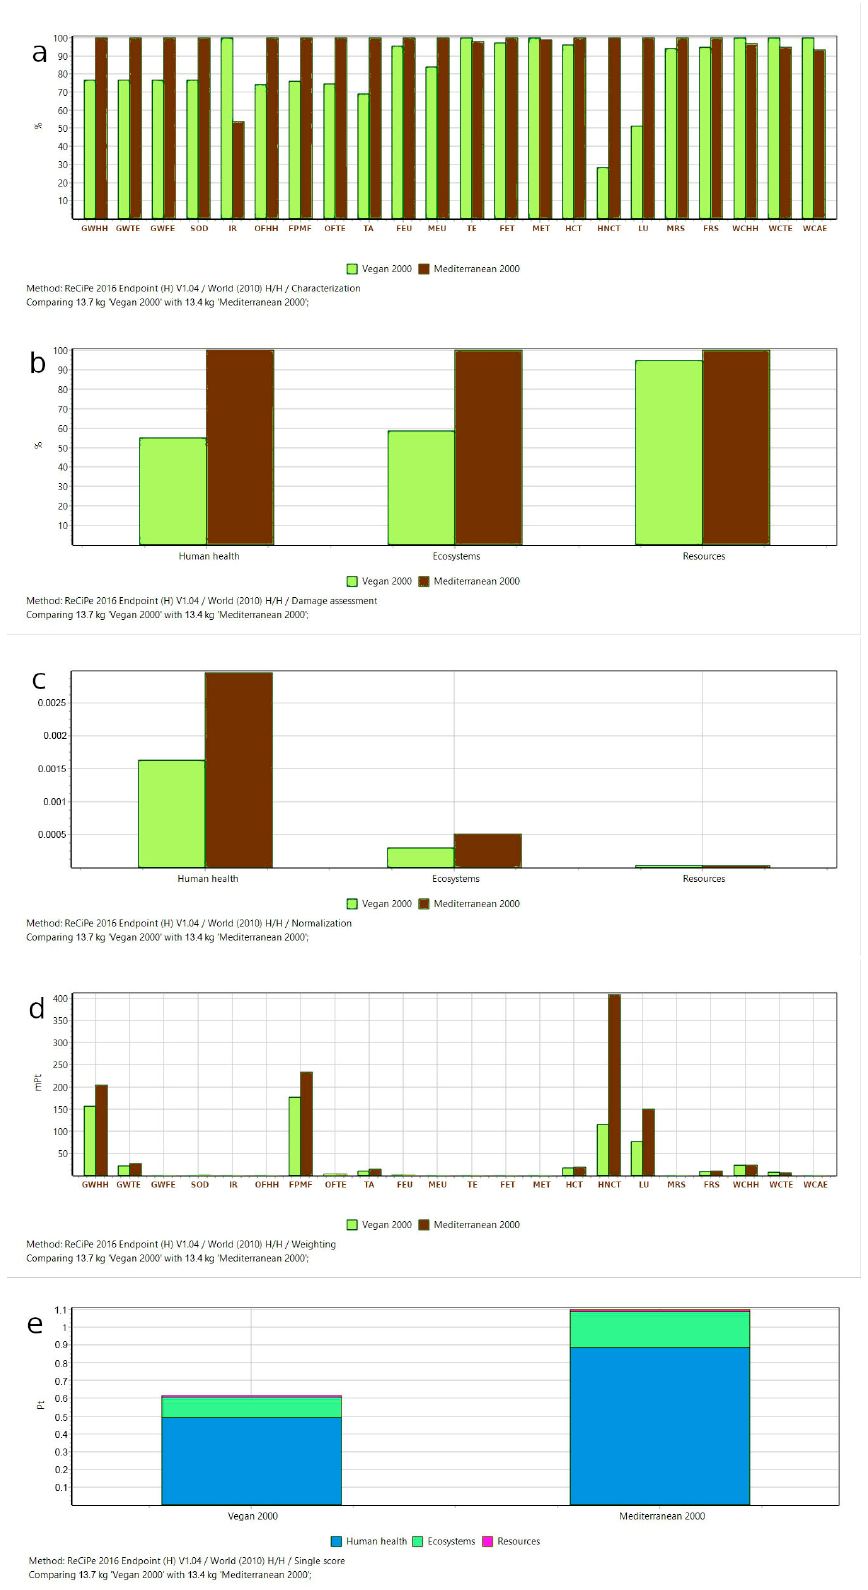
Figure 2. Comparison between Vegan diet and Mediterranean diet (2000 kcal): ( a ) Characterization; ( b ) Damage Assessment; ( c ) Normalization; ( d ) Weighting; ( e ) Aggregated Weighted Average